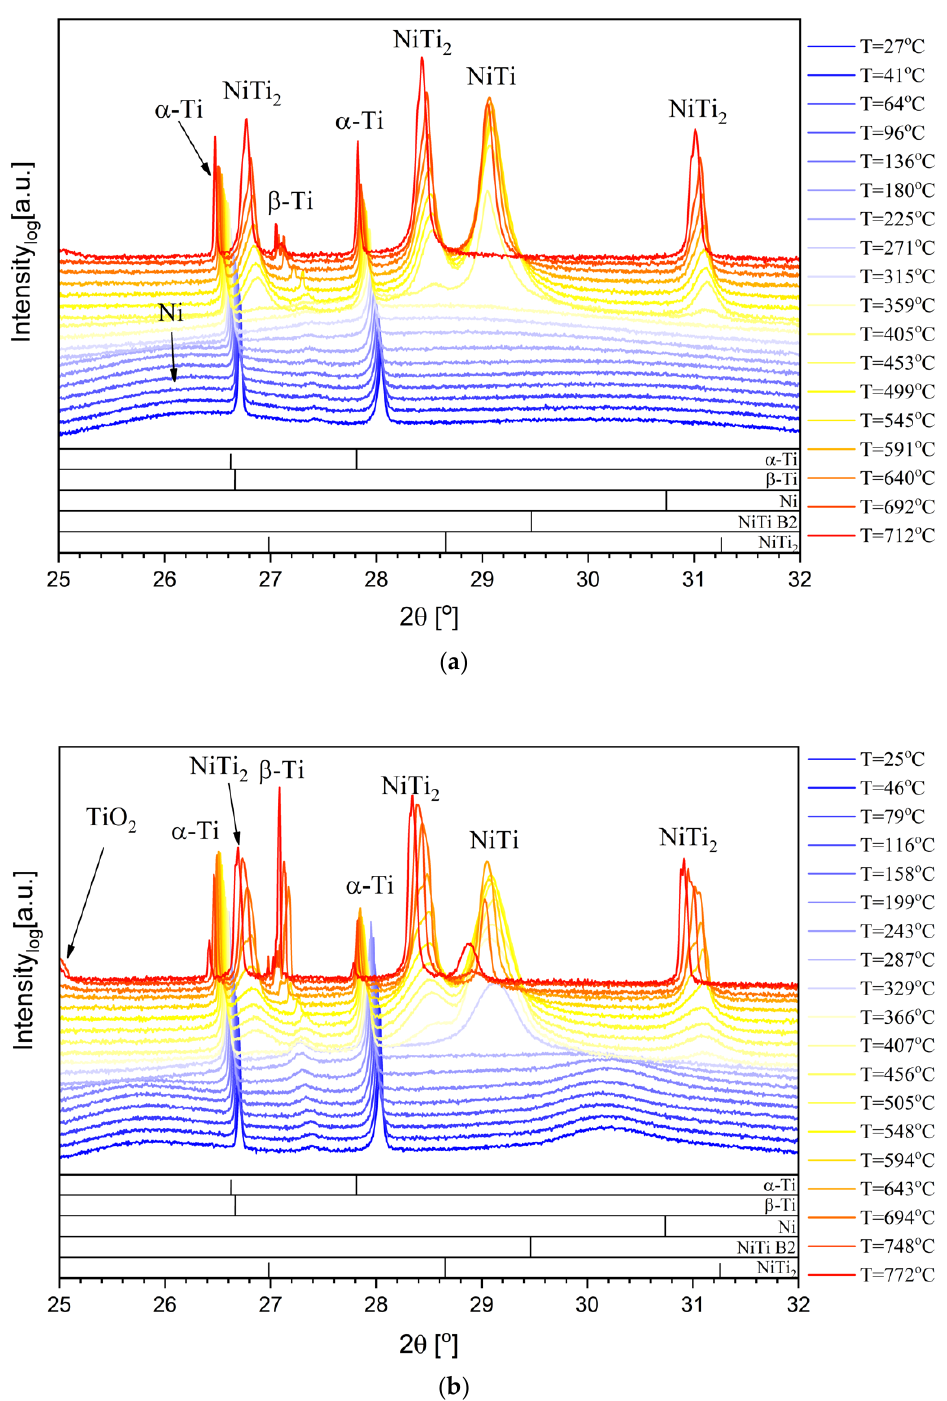
Figure 1. In situ synchrotron XRD phase evolution of multilayer thin films with ( a ) 12 nm and ( b ) 25 nm period.